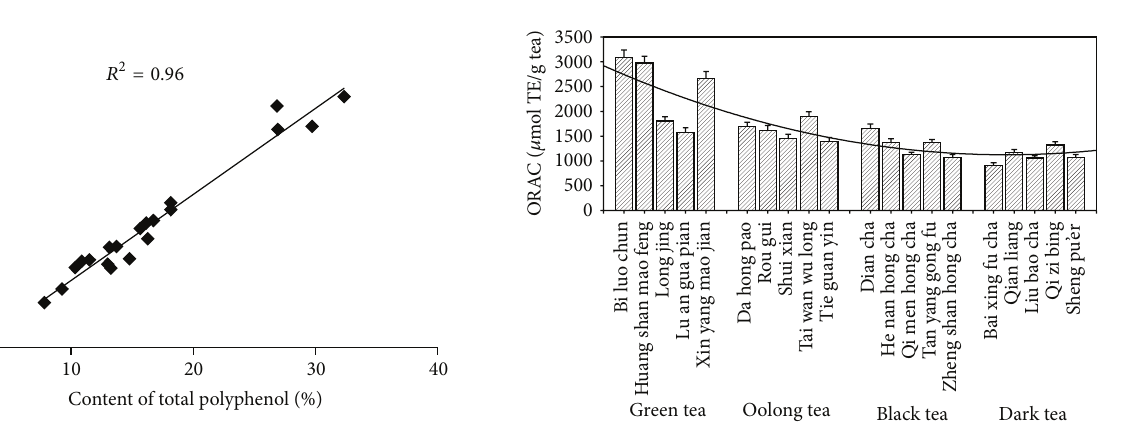
Figure 4: Oxygen radical absorbance capacity (ORAC) values of different samples in four types of